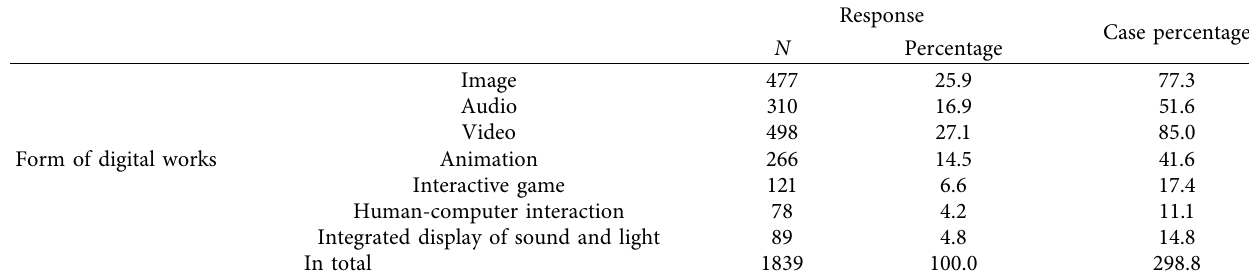
Table 14: Digital forms of the ICH works visited by the public.